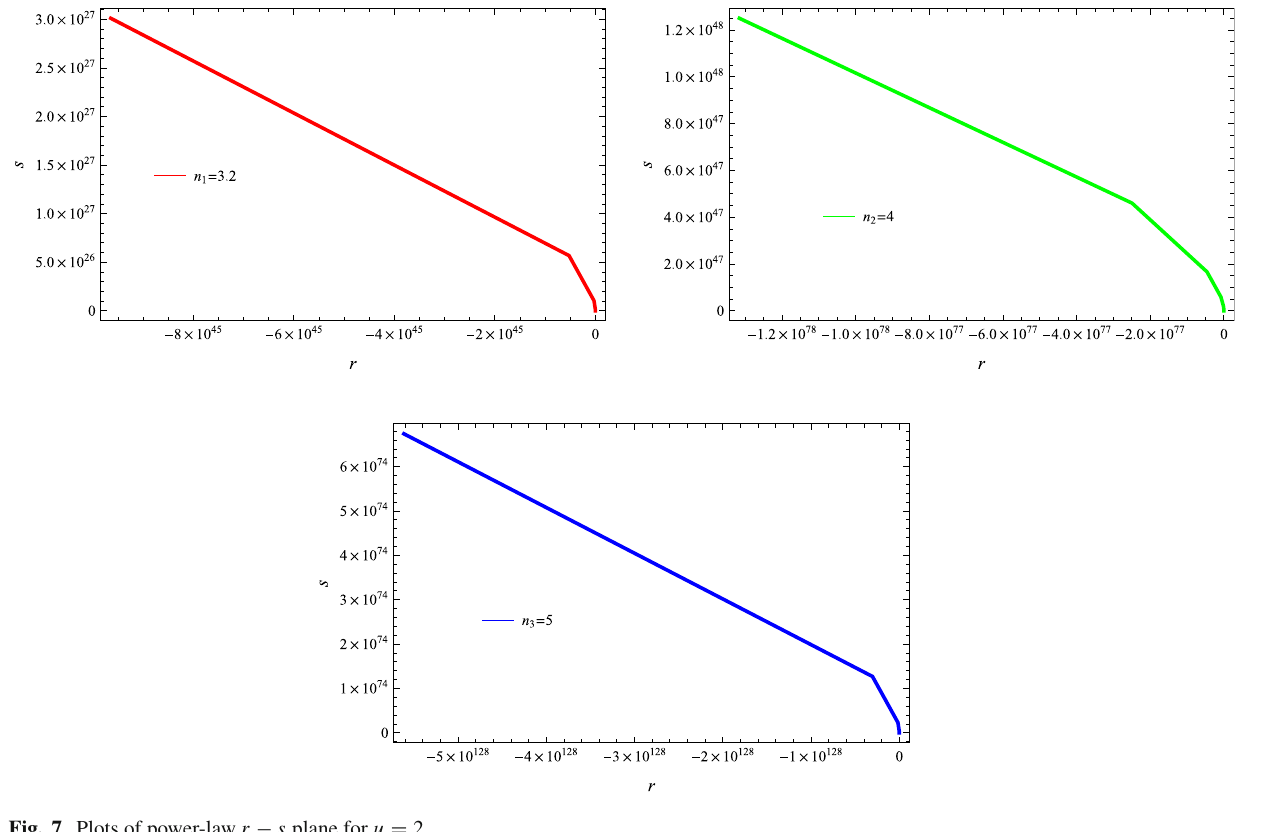
Fig. 7 Plots of power-law r − s plane for u =